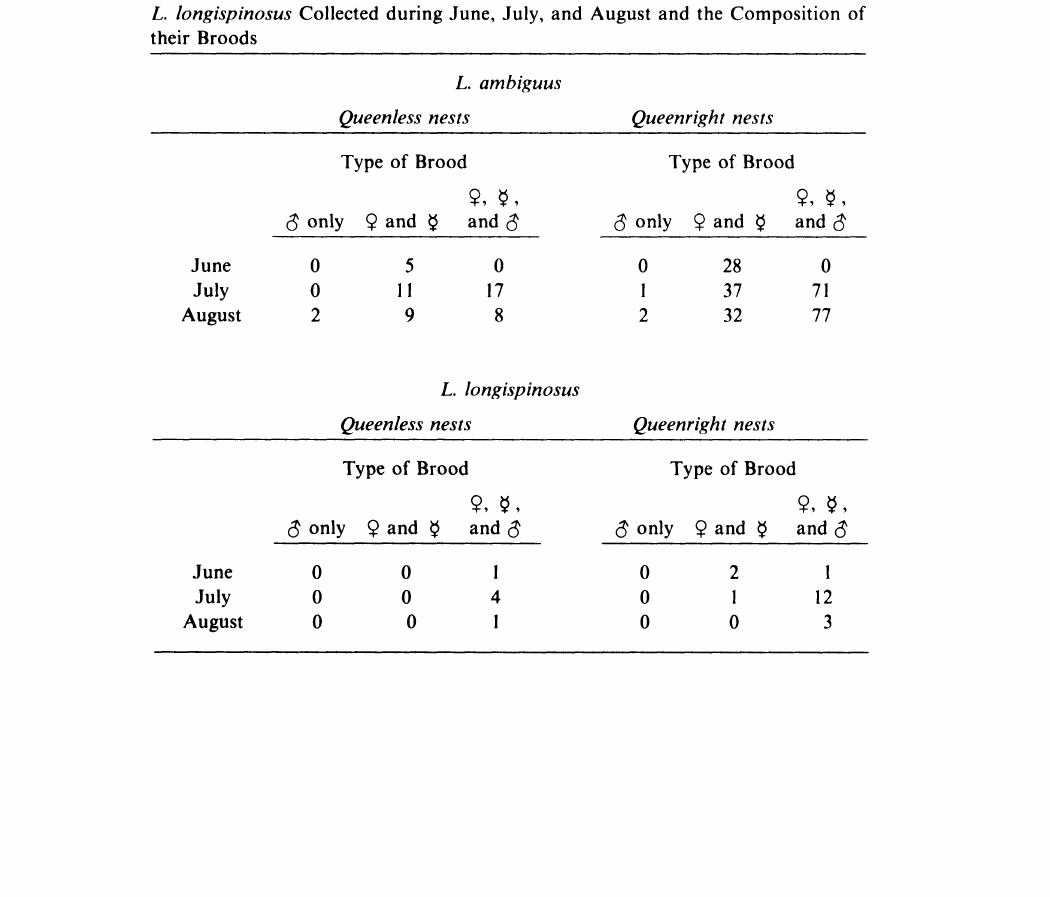
Table 3. Number of Queenright and Queenless Nests of L. ambiguus and L. longispinosus Collected during June, July, and August and the Composition of their